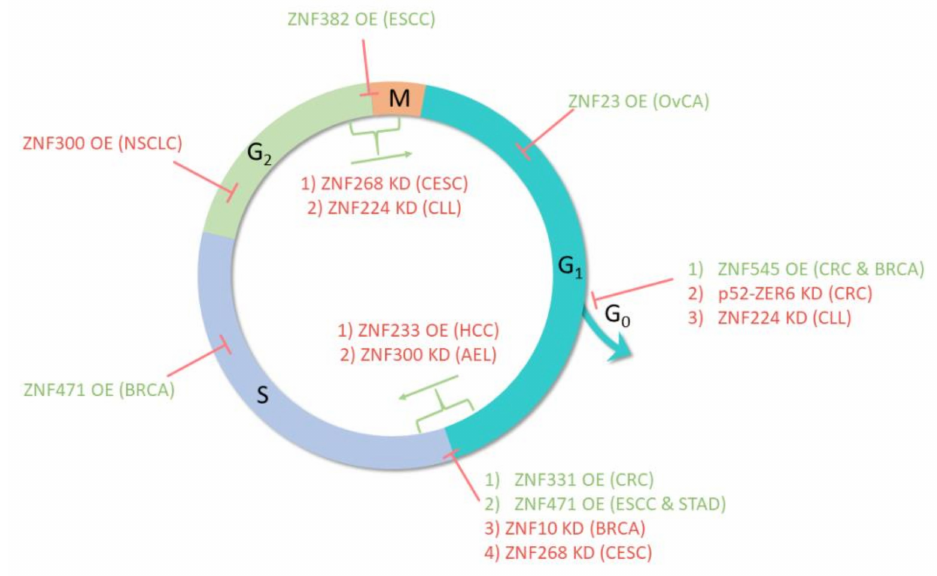
Figure 5. The influence of selected KRAB-ZFPs on cell cycle. The KRAB-ZFP factors may induce cell cycle arrest (red arrows) or promote phase transition (green arrows) in a given phase. Abbreviations: KD—knockdown, OE—overexpression, AEL—acute erythroid leukemia, BRCA—breast cancer, CESC—cervical cancer, CLL—chronic lymphocytic leukemia, CRC— colorectal cancer, ESCC—esophageal squamous-cell carcinoma, HCC—hepatocellular carcinoma, NSCLC—non-small cell lung cancer, OvCa—ovarian cancer, STAD—gastric